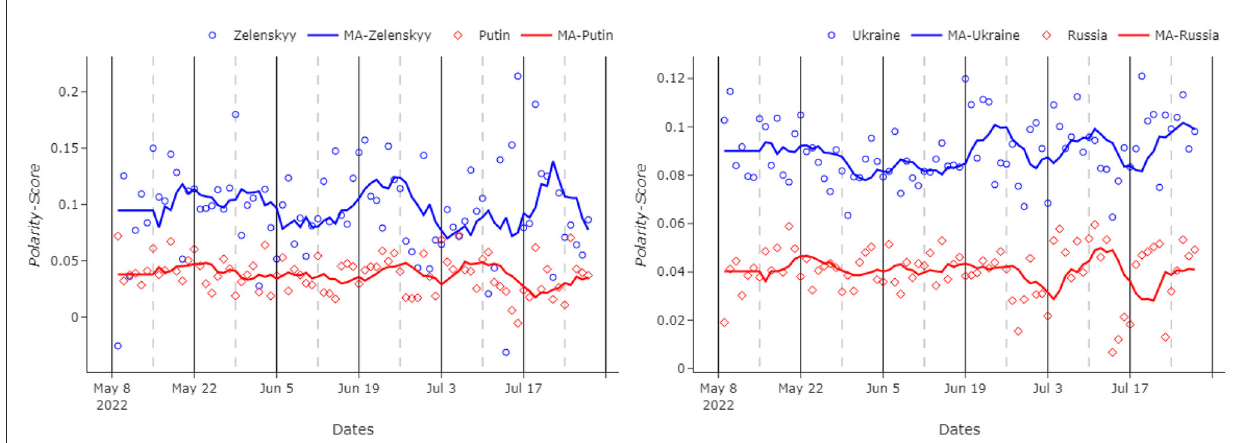
FIGURE5 (Left) Polarity score for the two leaders. (Right) Polarity score for the two countries. MA graphs for each figure refer to the 7-day moving average of the original data. Zelenskyy/Putin and Ukraine/Russia polarity scores are represented with different markers, as shown in the figure legends.